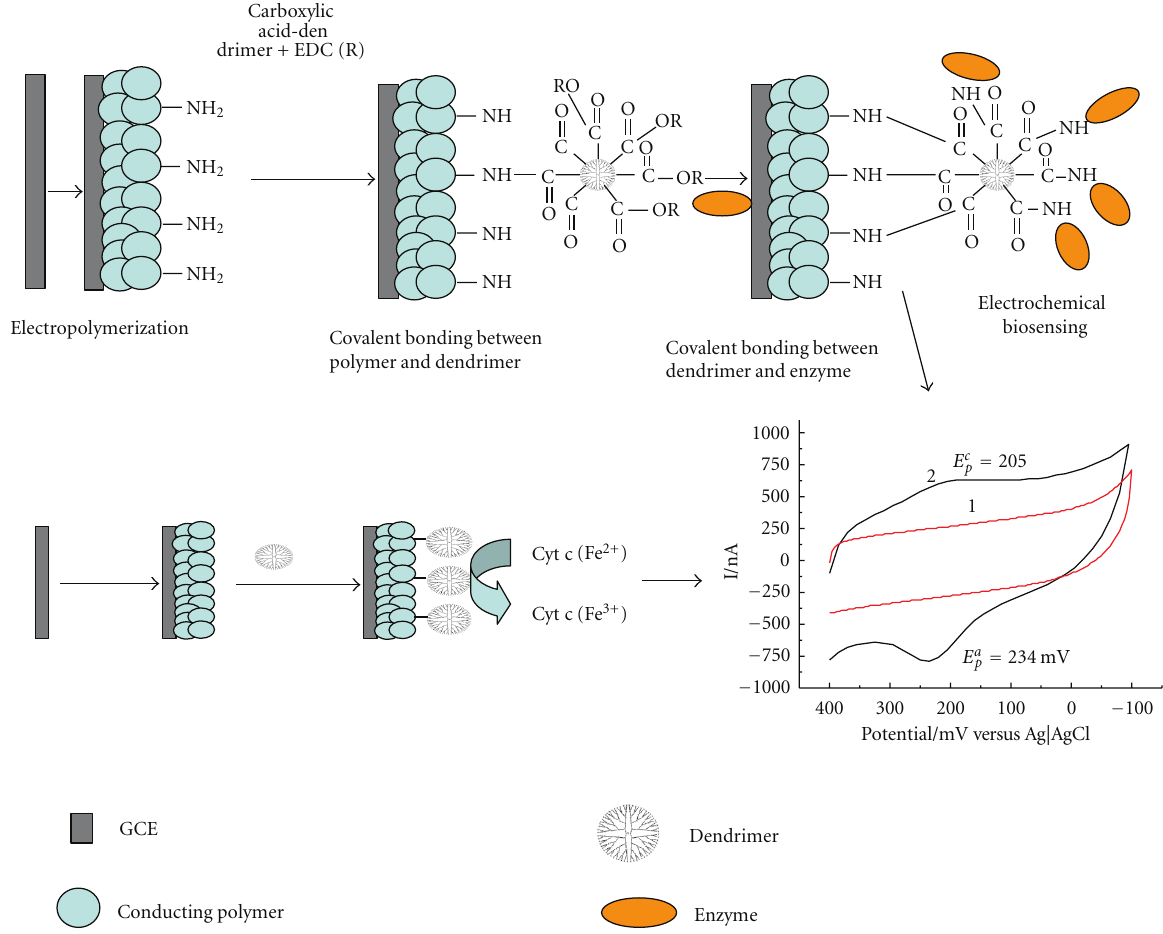
Figure 1: Shows the schematic presentation of enzymosensor using organic conducting